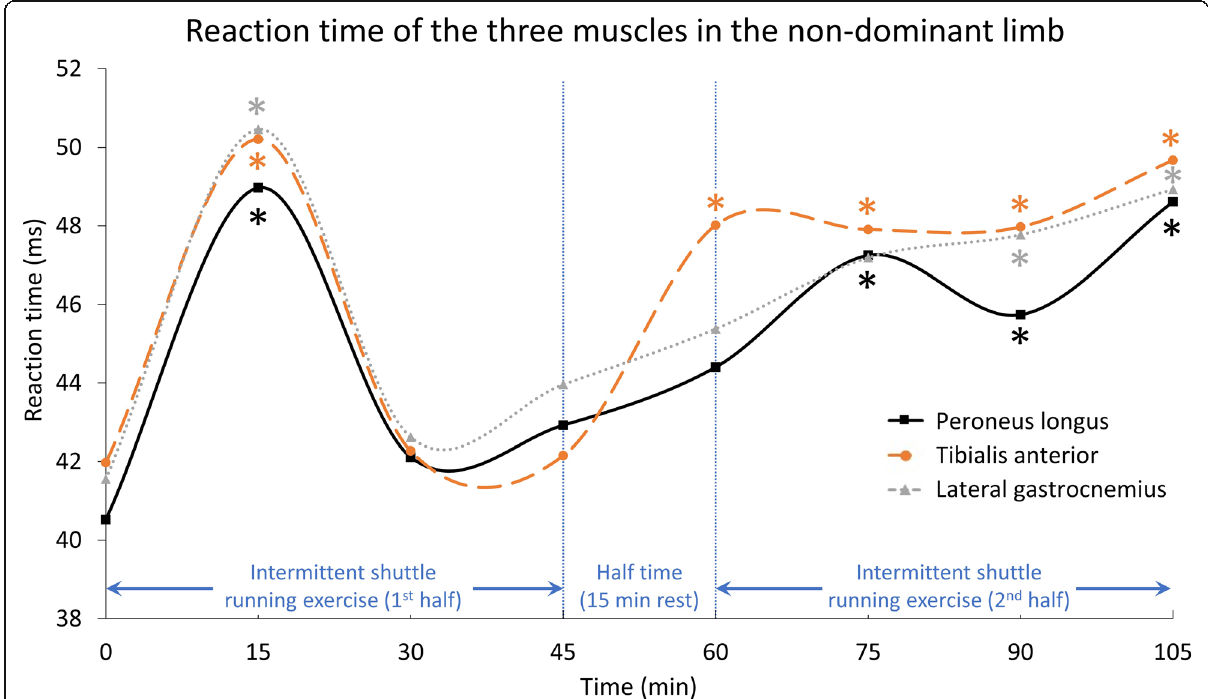
Fig. 4 Reaction time of the three muscles in the non-dominant